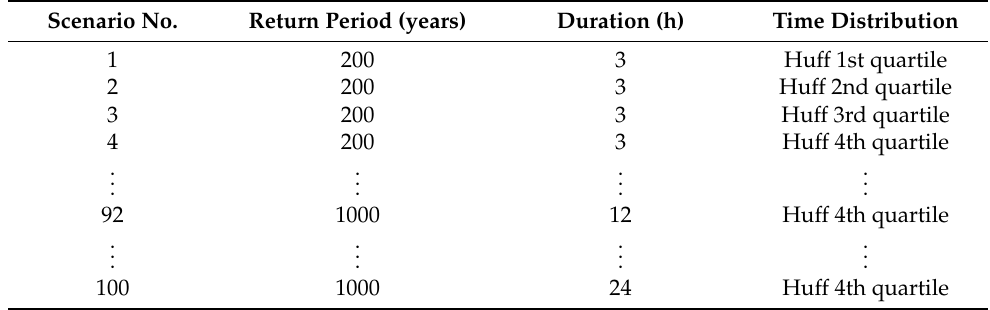
Table 1. One-hundred created rainfall